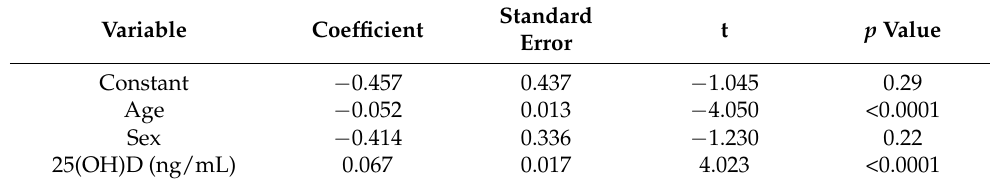
Table 4. Results of logistic binary regression analysis with death as a dependent variable.